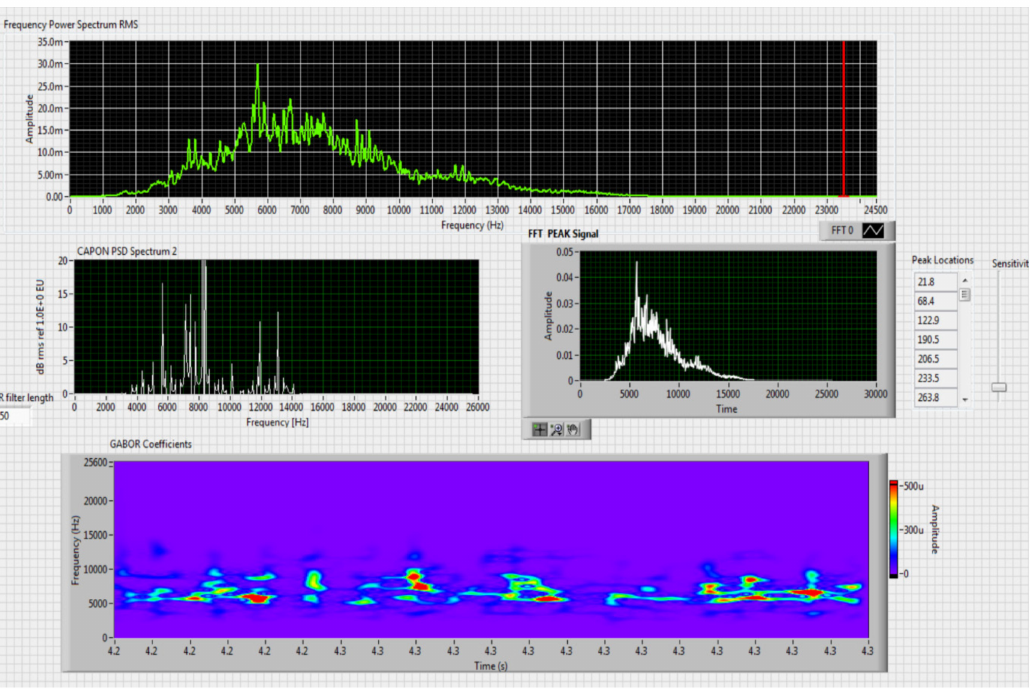
Figure 9. Results obtained for stationary distance 150 m, altitude 3 m.